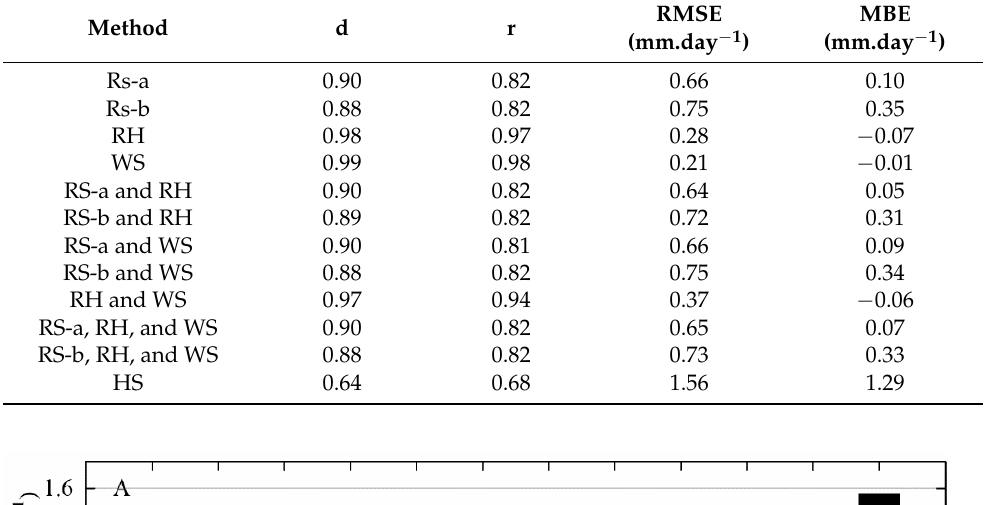
Table 2. Comparison between ET o computed from full data set and estimates of ET o with missing climatic data.